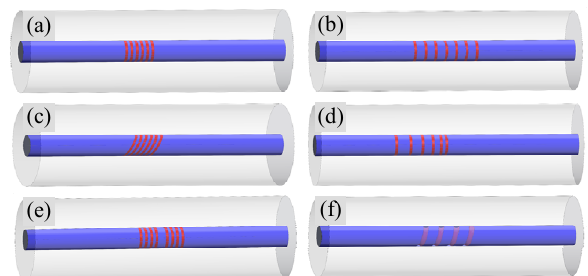
Fig. 1 Sketches of some typical grating structures: (a) uniform, (b) long-period, (c) tilted, (d) chirped, (e) phase-shift, and (f) helical grating structures.